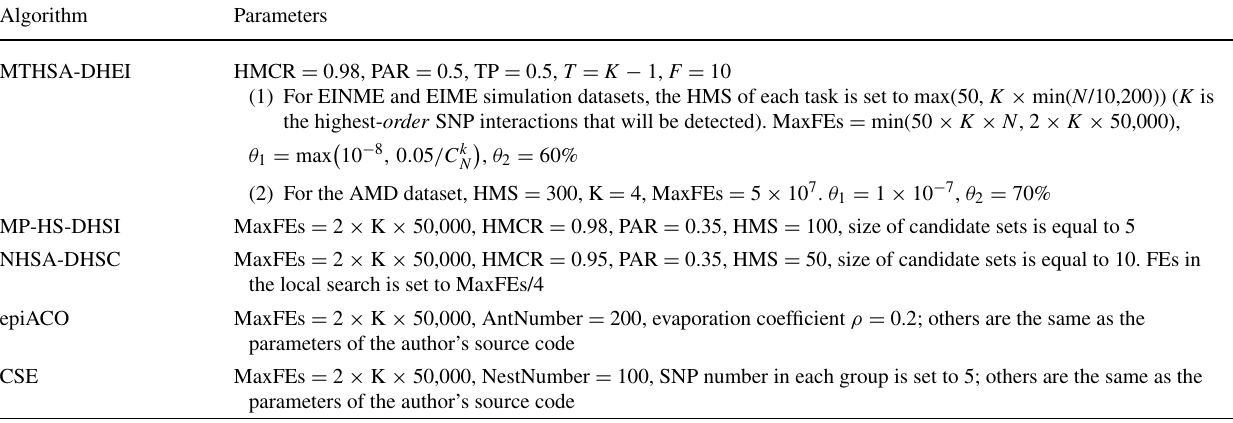
Table 1 Parameters of the five algorithms for detecting high- order epistatic interactions